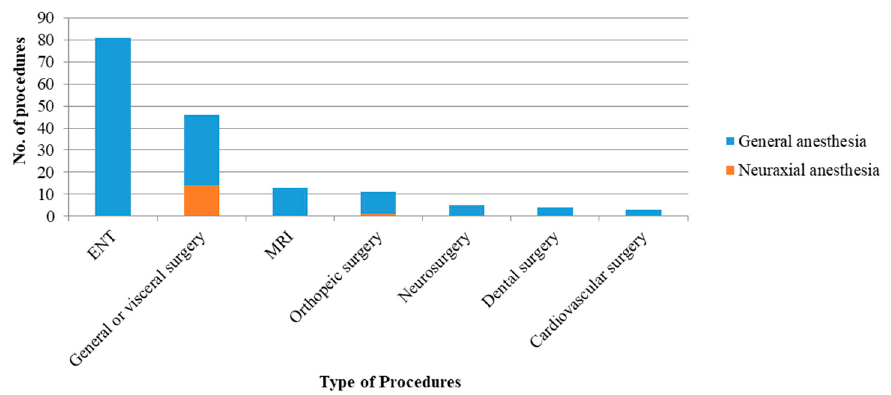
Figure 1. Number of various intervention procedures under general (blue bar) or neuraxial (orange bar) anesthesia.